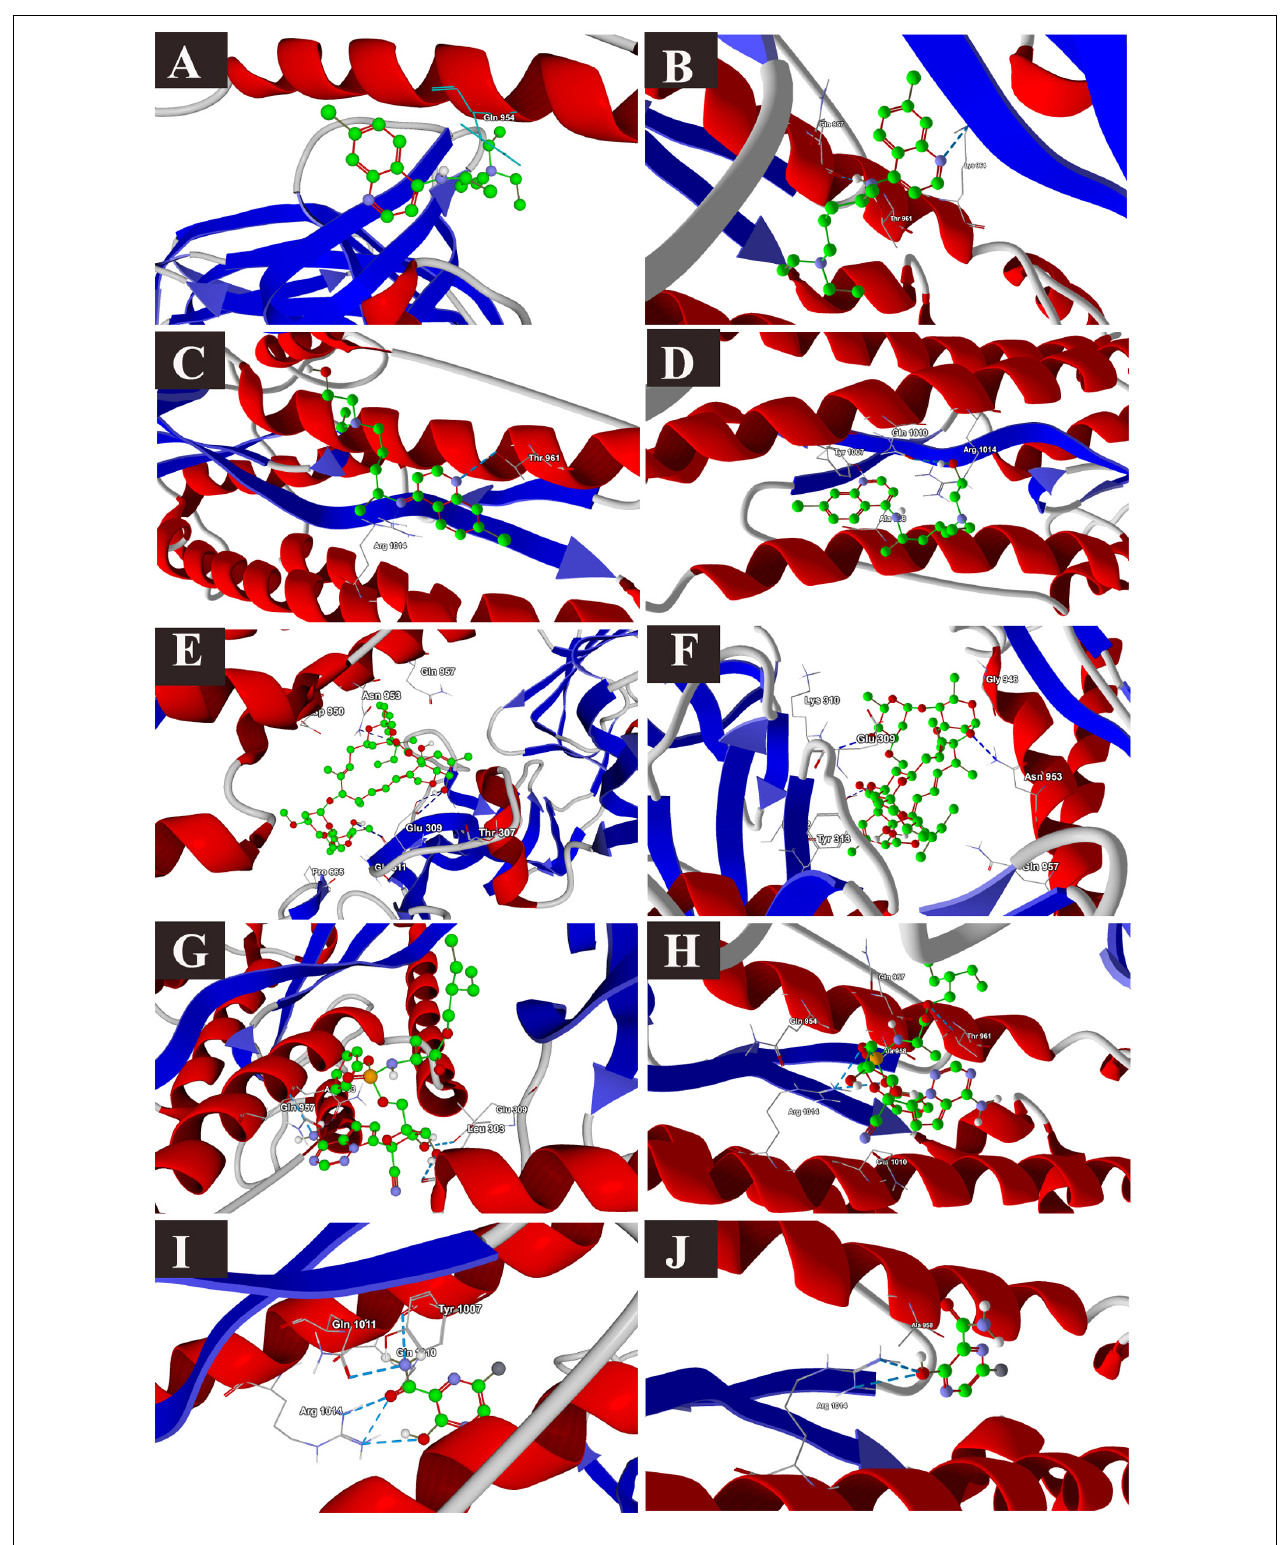
FIGURE 1 | Binding interactions of selected drugs with SARS-CoV-2 spike glycoprotein. (A) chloroquine closed state, (B) chloroquine open state, (C) hydroxychloroquine closed state, (D) hydroxychloroquine, open state, (E) ivermectin closed state, (F) ivermectin, open state (G) remdesivir closed state, (H) remdesivir, open state, (I) favipiravir, closed state, (J) favipiravir, open state.